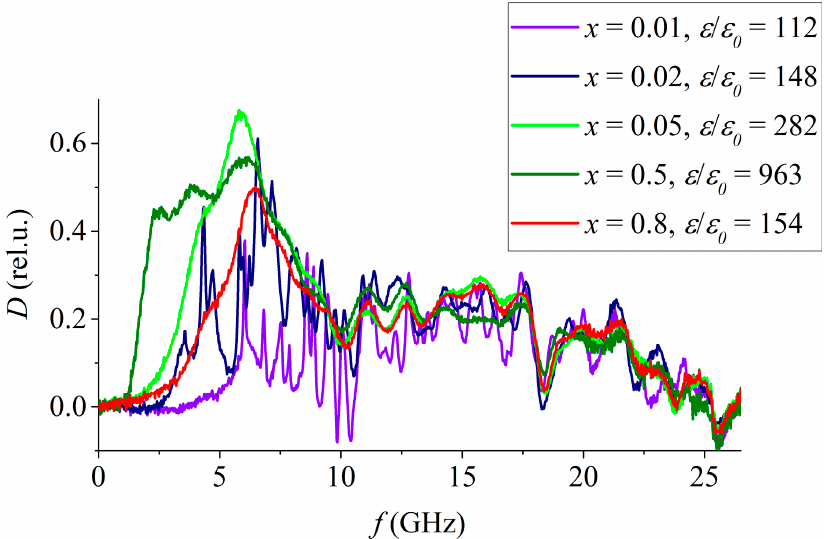
Figure 9. Frequency dependence of the absorption coefficient SS of the PZT system with different concentrations of PT. concentrations of PT.